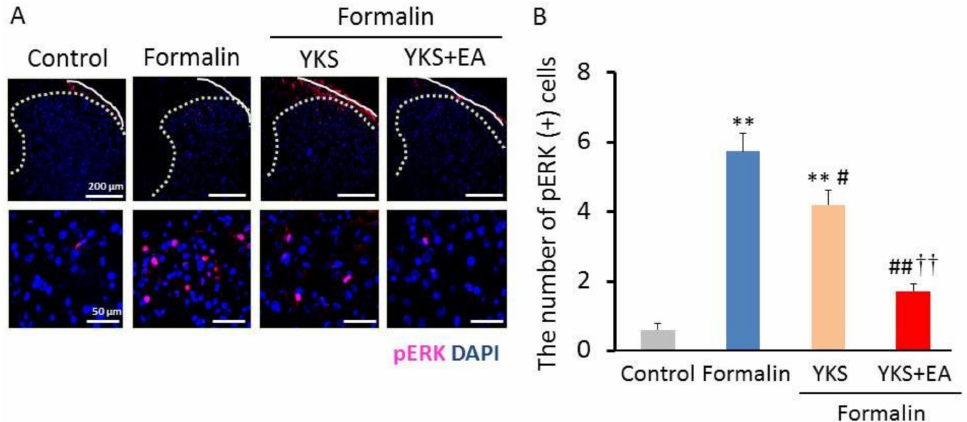
Figure 3. Immunohistochemical analysis of pERK1/2 in the dorsal horn of the spinal cord (L5). Images of pERK1/2 immunoreactivity (red) are shown ( A , upper; original magnification × 20). White bars = 200 µ m. The upper panels are the enlarged images of pERK1/2 immunoreactivity ( A , lower; original magnification × 60). White bars = 50 µ m. ( B ) The number of pERK1/2-positive cells are shown. n = 5, ** p < 0.01 (vs. the control group); # p < 0.05, ## p < 0.01 (vs. the formalin group); †† p < 0.01 (vs. the YKS group).